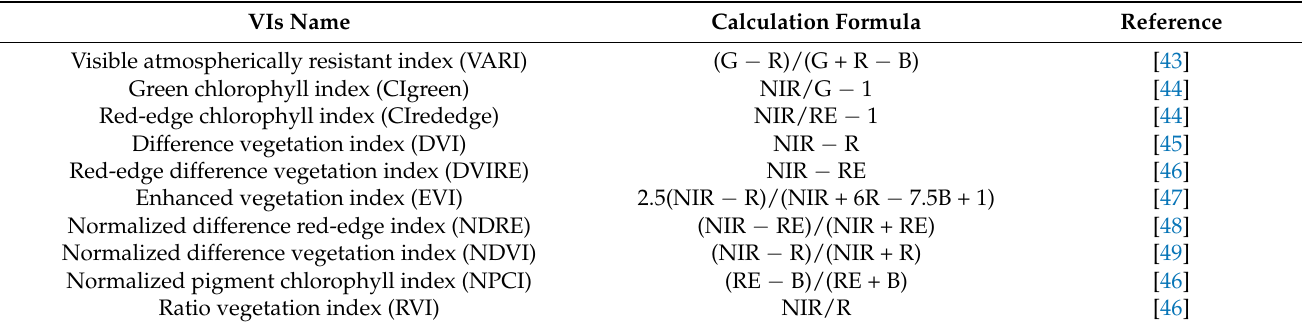
Table 1. Formulas and sources of spectral VIs for monitoring wheat